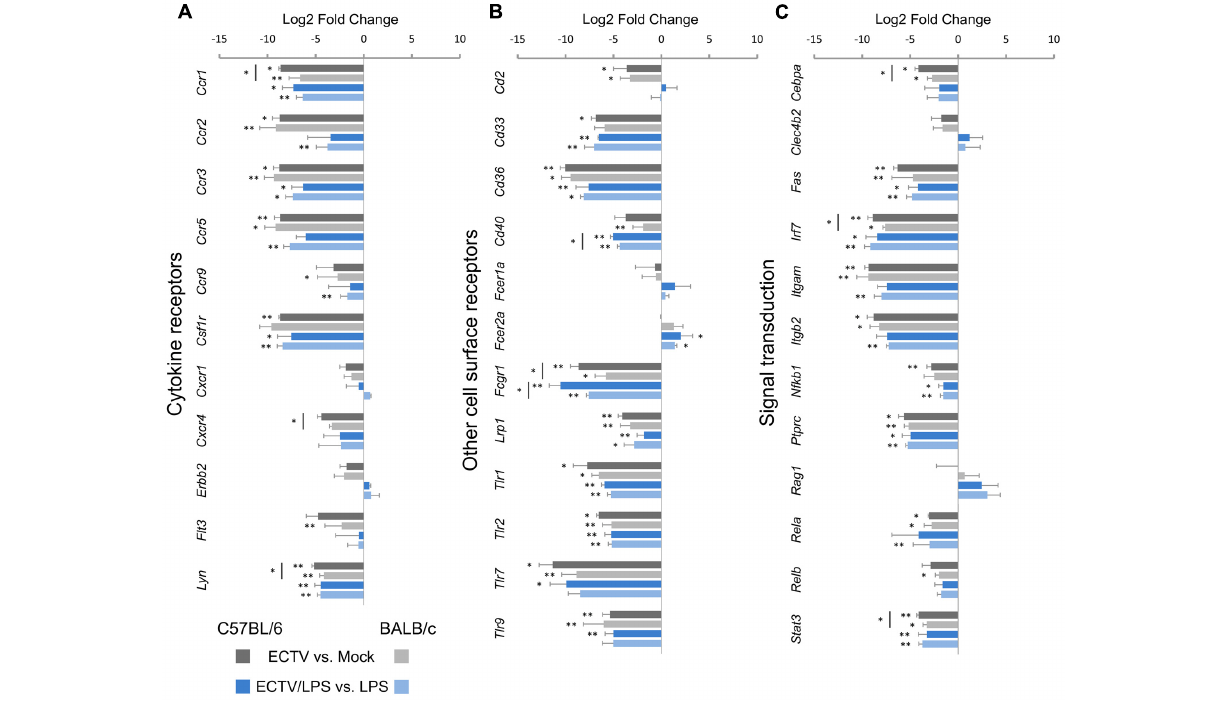
( Figure 7A ). ECTV-infection significantly ( P > 0.01)